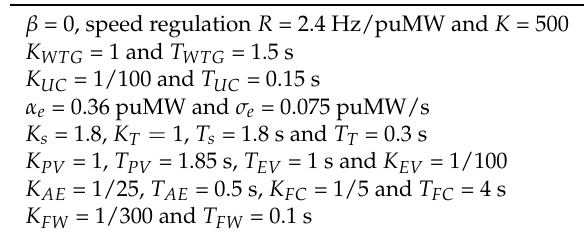
Figure 14. ( a ) First input membership functions for the second FLC scheme; ( b ) second input membership functions for the second FLC scheme; ( c ) output membership functions for for the second FLC scheme. Table 1. Hybrid power system